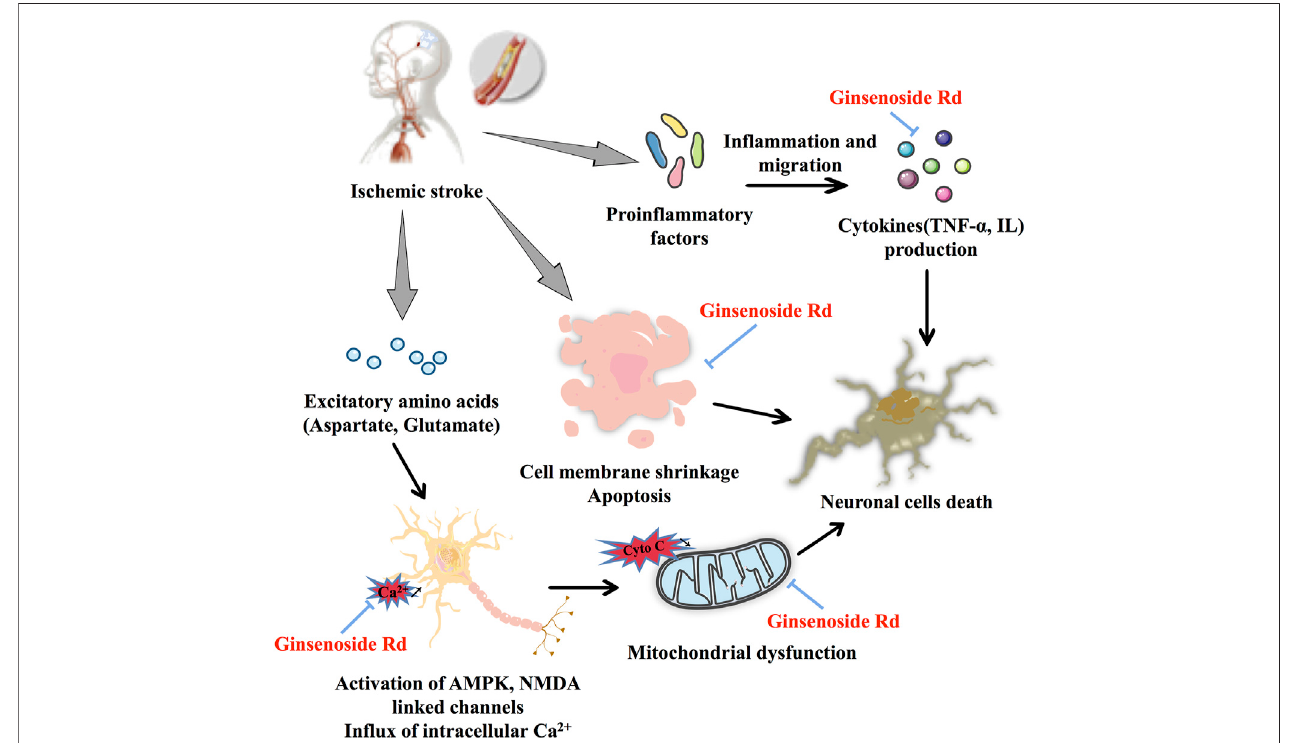
FIGURE 2 | Protective effect of ginsenoside Rd on ischemic